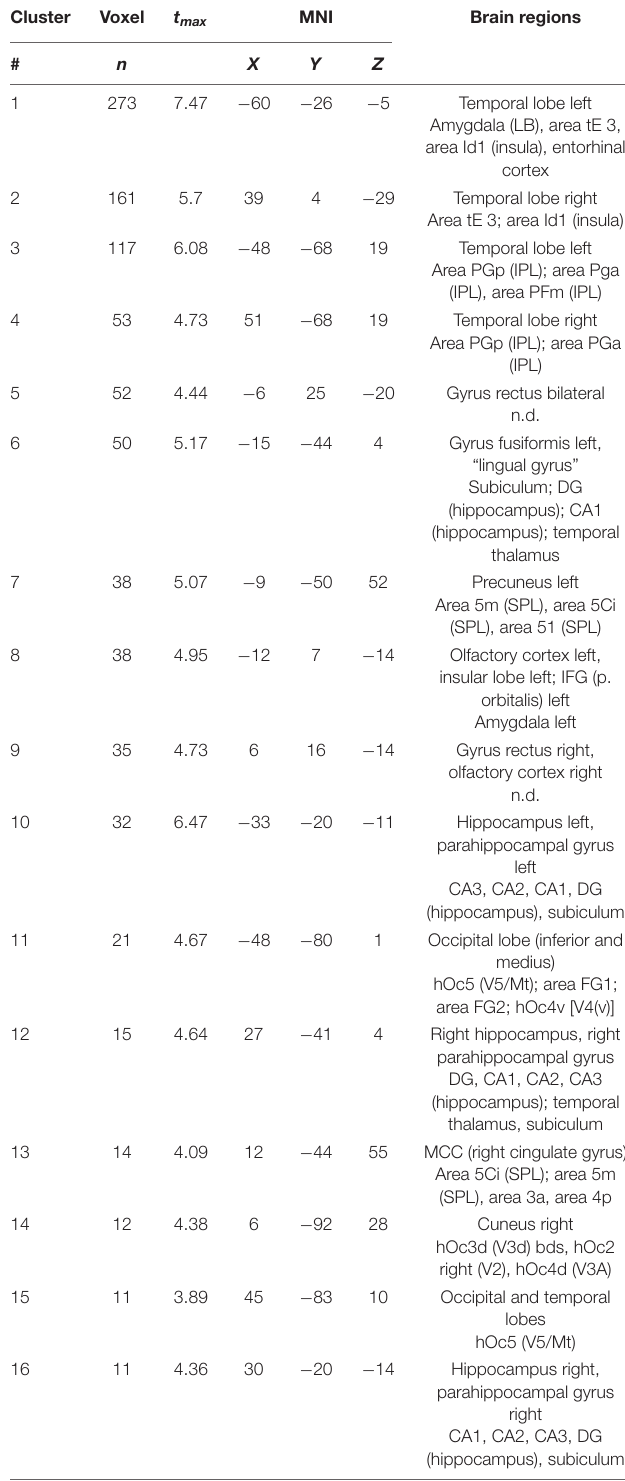
TABLE 2 | Results of the fMRI Experiment 1: WN > RN. Cluster Voxel